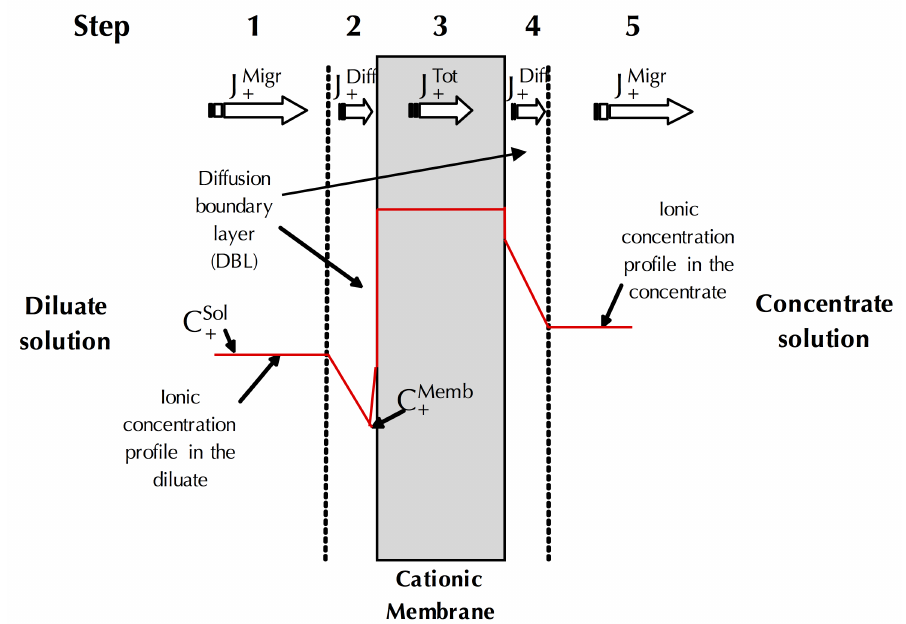
Figure 4. Schematic ion concentration profiles in the di ff usion boundary layers (DBL) close to a cation-exchange membrane under an electric field, under the limiting current density, and the di ff erent mass transfer mechanisms involved in cation migration (Adapted from Bazinet and Castaigne